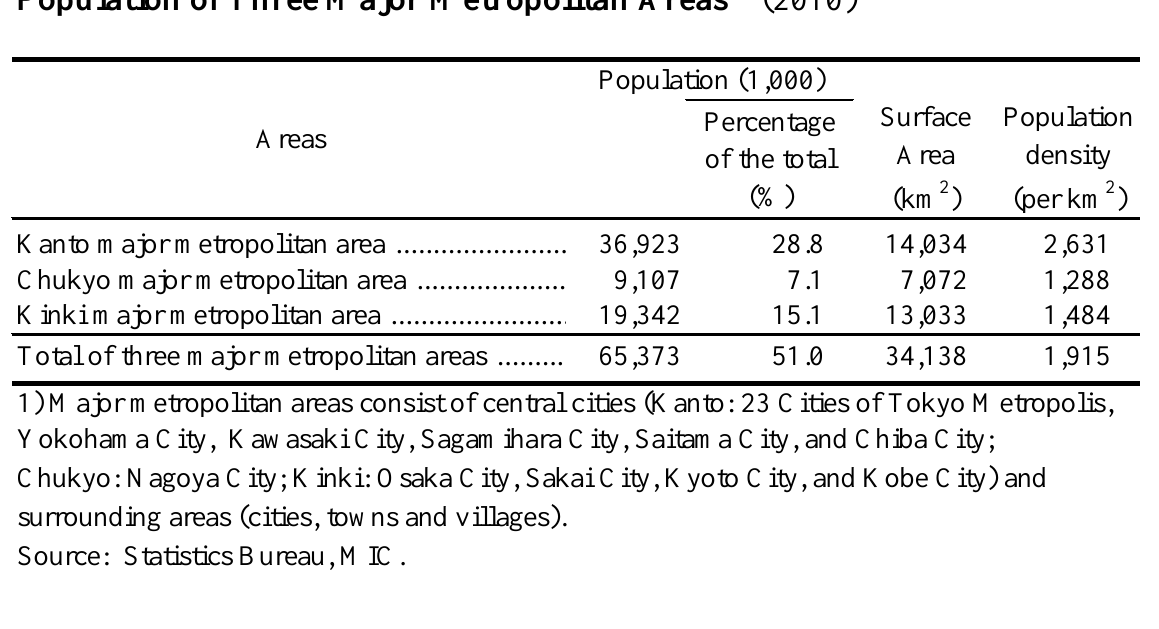
Population of Three Major Metropolitan Areas 1)